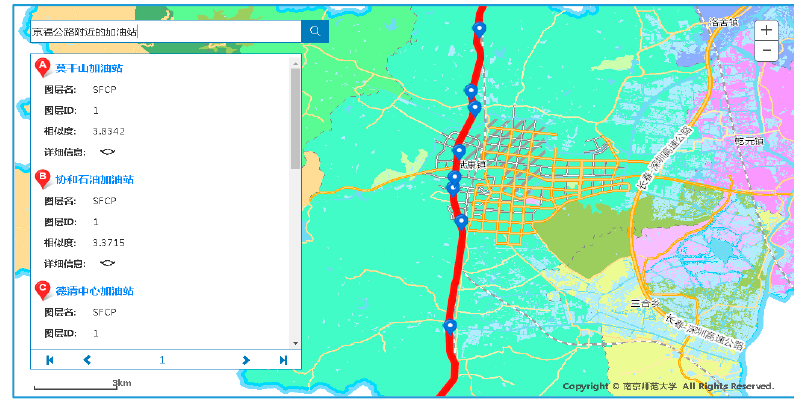
Figure 14. “Gas stations near the Jing-Fu highway.”